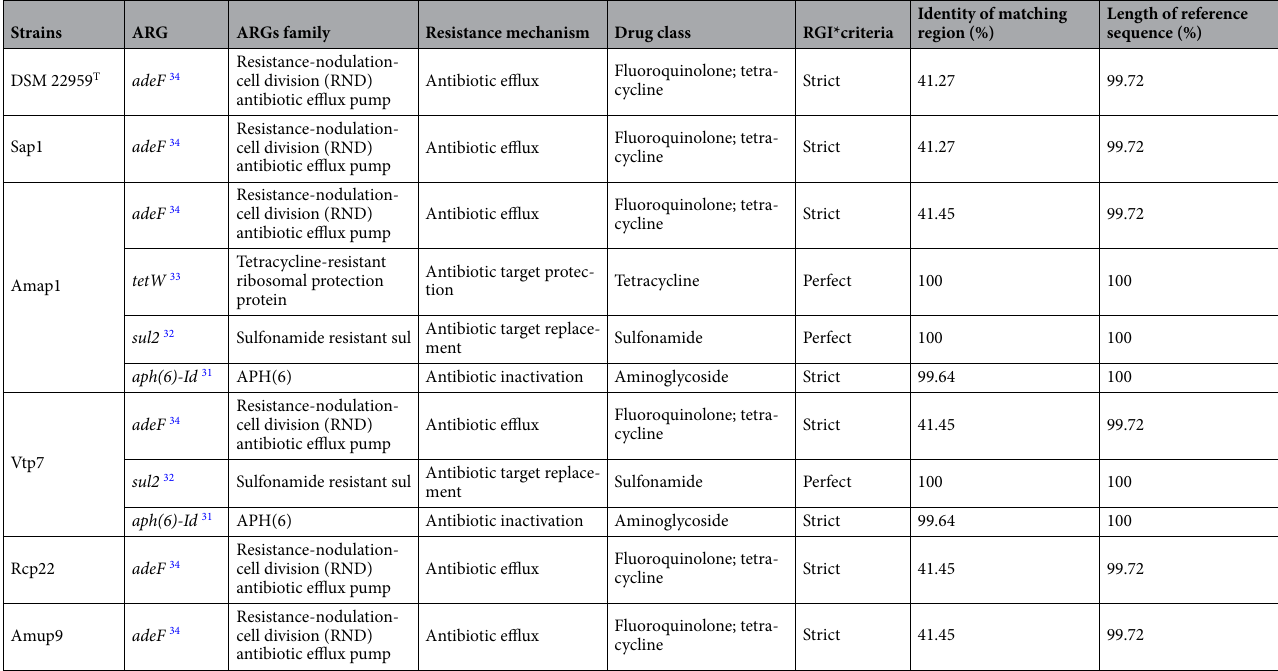
Table 2. Identification of ARGs in the genome of A. muciniphila strains, according to CARD database 30 . * RGI Resistance Gene